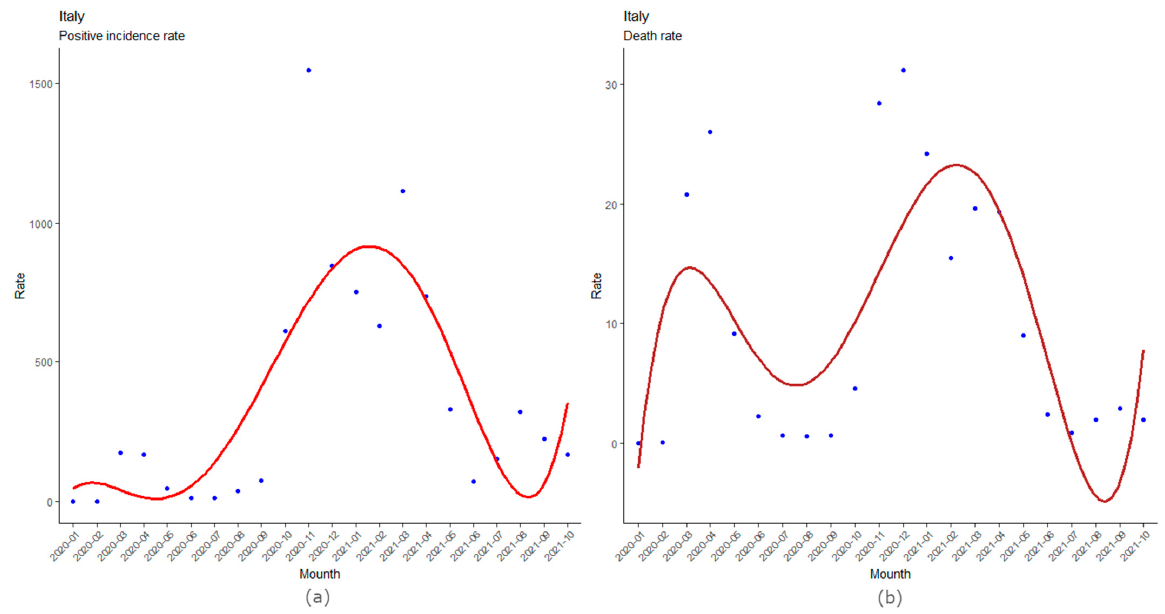
Figure 3. ( a ) Incidence rates. Regression p -value: p = 0.0039. ( b ) Mortality rates. Regression p -value: p = 0.0117.